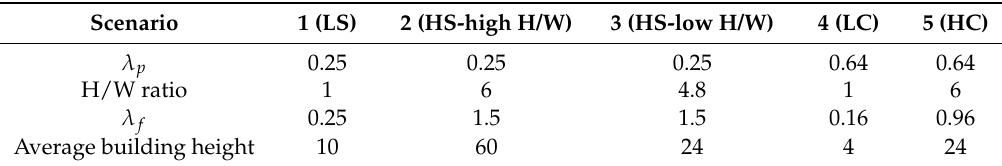
Table 4. The urban morphology of the five scenarios.